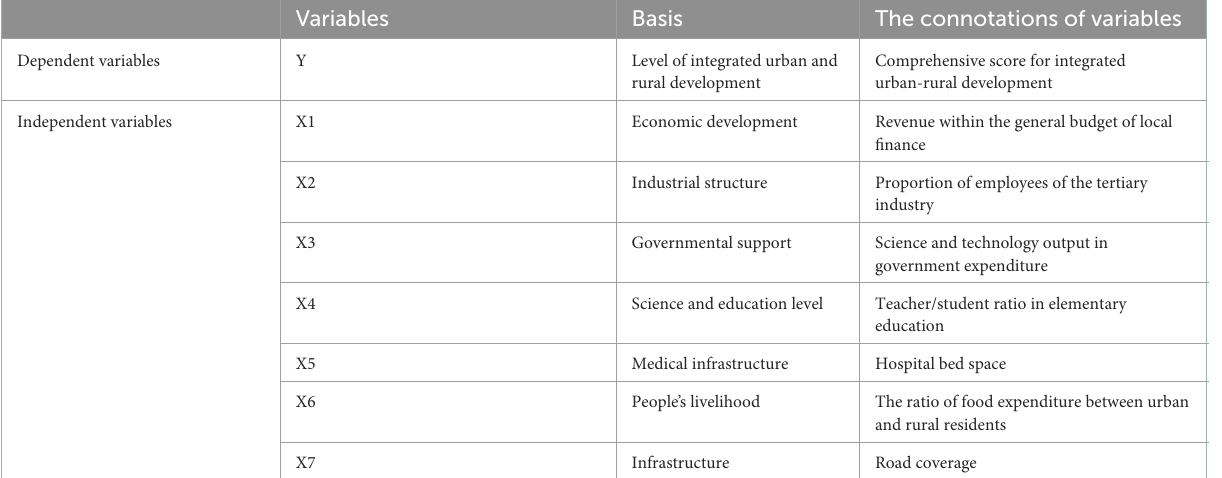
TABLE 3 Influencing factors of urban-rural integration development